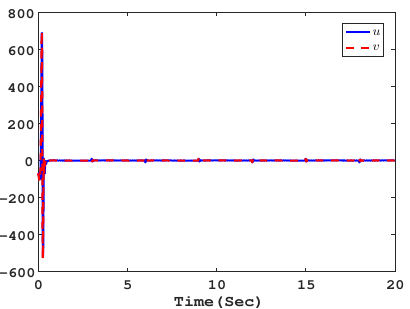
Figure 7. The red line is the trajectory of the time-triggered controller, and the blue line is the trajectory of the event-triggered controller.